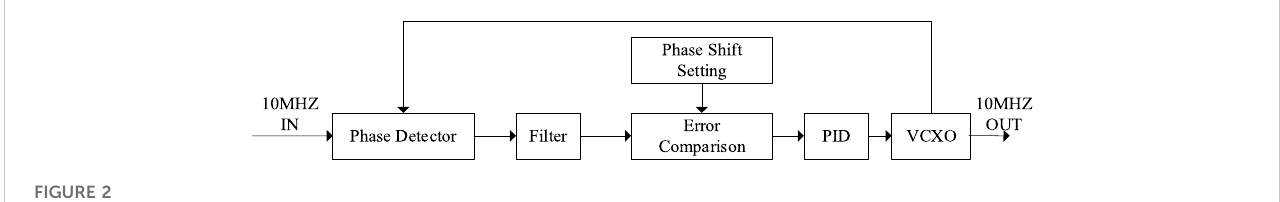
FIGURE 2 Schematic diagram of the carrier processing module.